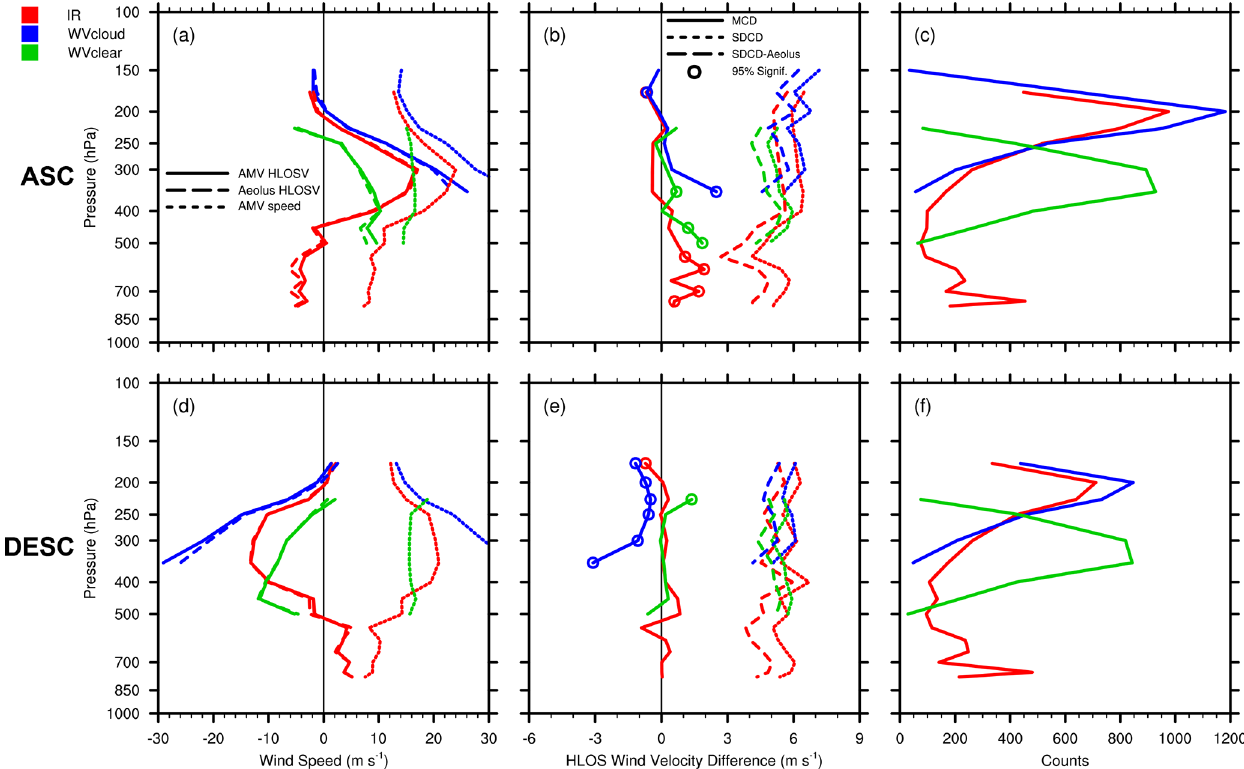
Figure 1. Vertical comparisons of co-located GOES-16 AMVs and RAY winds in the tropics (30 ◦ S to 30 ◦ N). The top row shows Aeolus ascending orbits (ASCs), (a) mean AMV (solid lines), and RAY (dashed lines) winds (ms − 1 ), (b) MCDs (solid), SDCDs (short dashed), and AMV HLOSV errors, as represented by the SDCD–Aeolus L2B uncertainty (long dashed; ms − 1 ), and (c) co-location counts. Panels (d– f) are the same as panels (a–c) but for Aeolus descending orbits (DESCs). Colors denote the AMV type, with IR (red), WVcloud (blue), and WVclear (green). Colored open circles indicate levels where MCDs are statistically significant at the 95% level ( p value < 0.05), using the paired Student’s t test. Vertical zero lines are displayed in the left and center panels in black. Levels with observation counts > 25 are